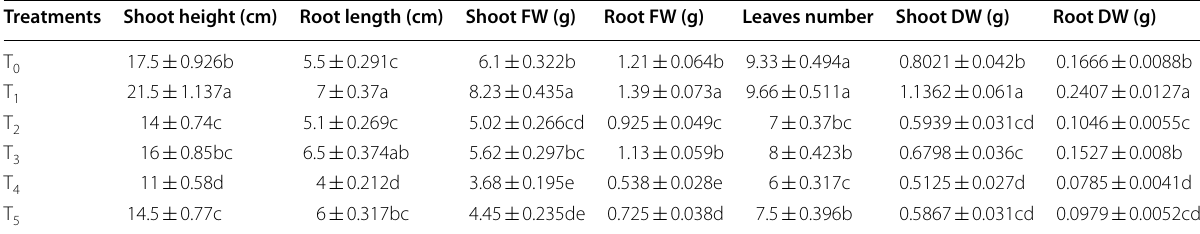
T 0 , T 2 and T 4 represent tomato plants grown under 0, 50 and 100 mM NaCl stress, while T 1 , T 3 and T 5 represent tomato plants grown with T. viride under 0, 50 and 100 mM NaCl stress * Data are mean of 5 replicates standard error ± Different letters in the same column mean significant difference at the p < 0.05 level by Duncan’s new multiple range test